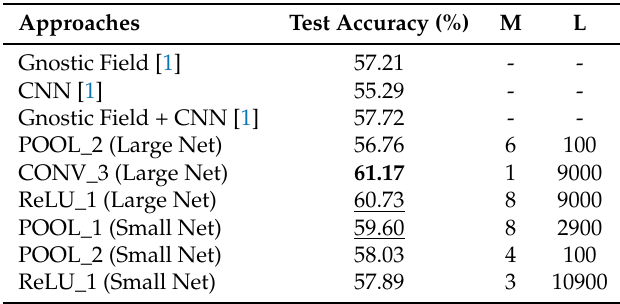
Table 8. Comparison with state-of-the-art approaches on the VAIS dataset (IR images only). Approaches Test Accuracy (%) M L Gnostic Field [1] 57.21 - - CNN [1]